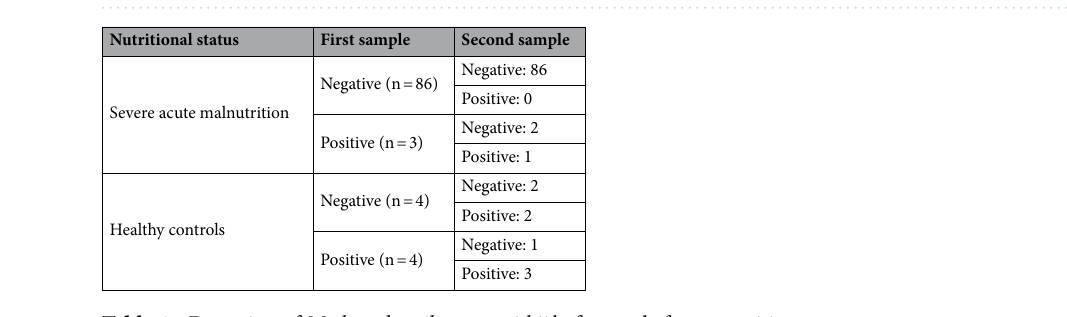
Table 4. Detection of Methanobrevibacter smithii before and after